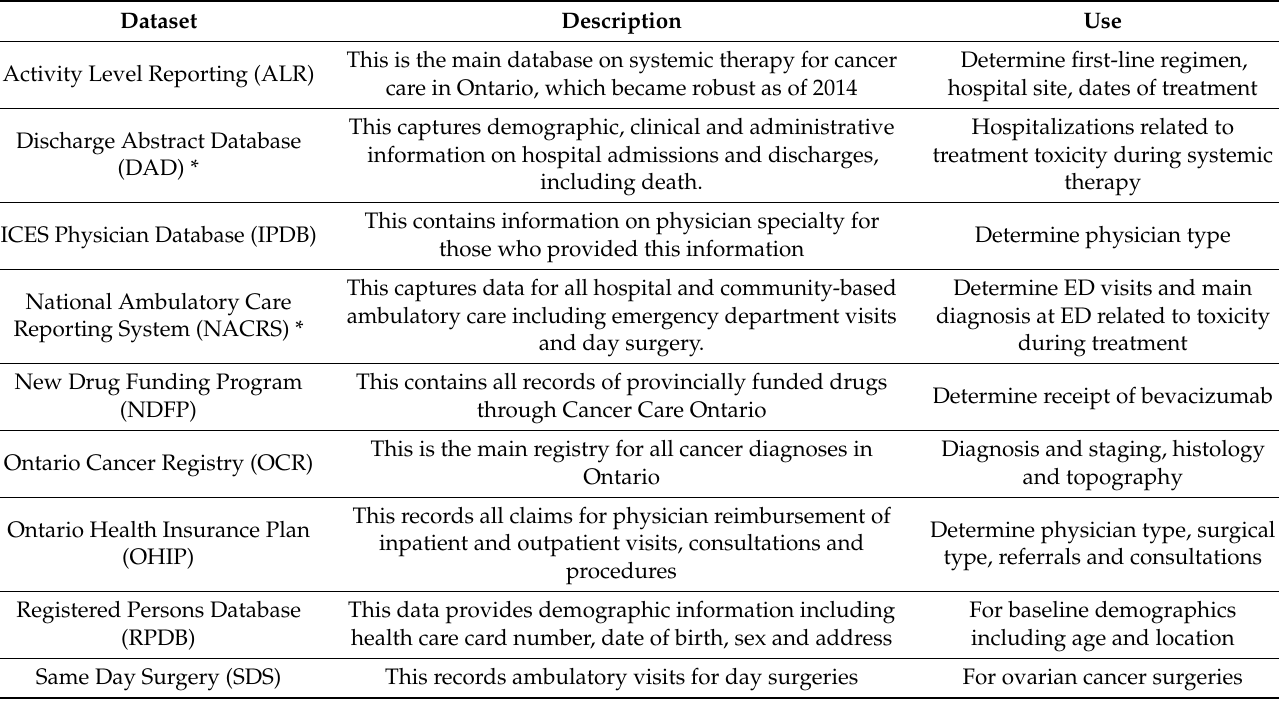
Table A1. List of datasets accessed at